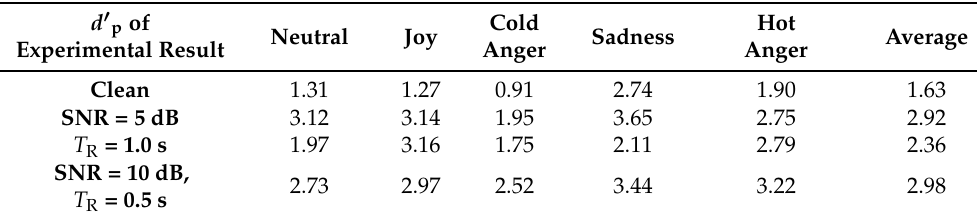
Table 2. Discrimination index of vocal-emotion-recognition results in clean/noisy/reverberant/noisy reverberant